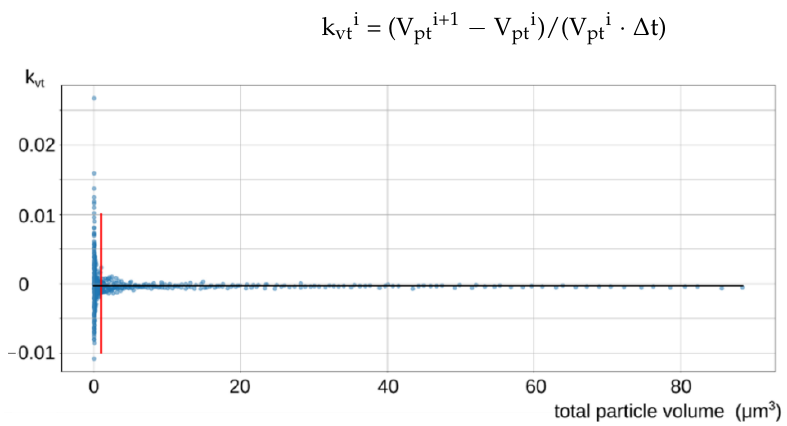
Figure 3. Loss factor with a line splitting the low uncertainty interval.